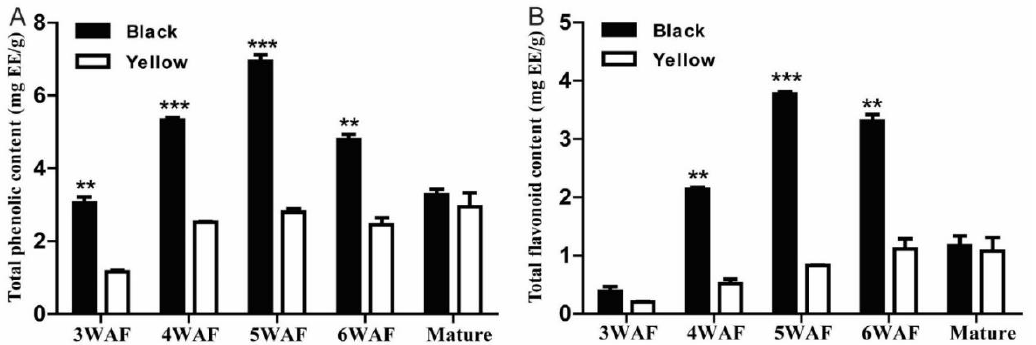
Figure 1. Total phenolic and flavonoid content in developing seeds of yellow- and black-seeded B. napus . ( A ). Total phenolic content; ( B ). Total flavonoid content. **, and *** indicate significance at p < 0.05, 0.01 and 0.001, respectively. WAF, week after flowering; EE, epicatechin equivalents.